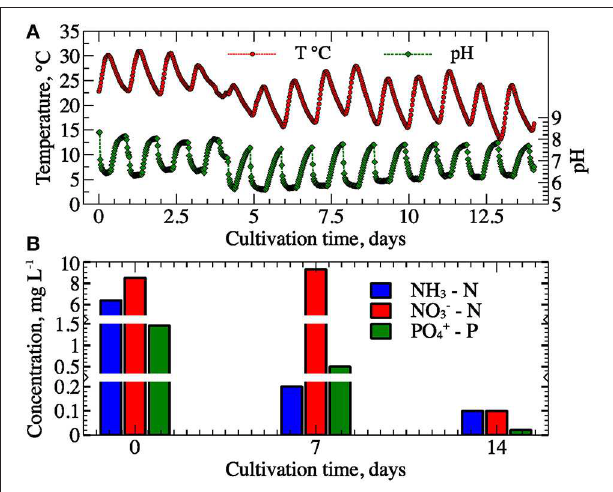
FIGURE 2 | Semi-hourly (A) temperature and pH and daily (B) nutrient concentrations in the filamentous algal treatment systems